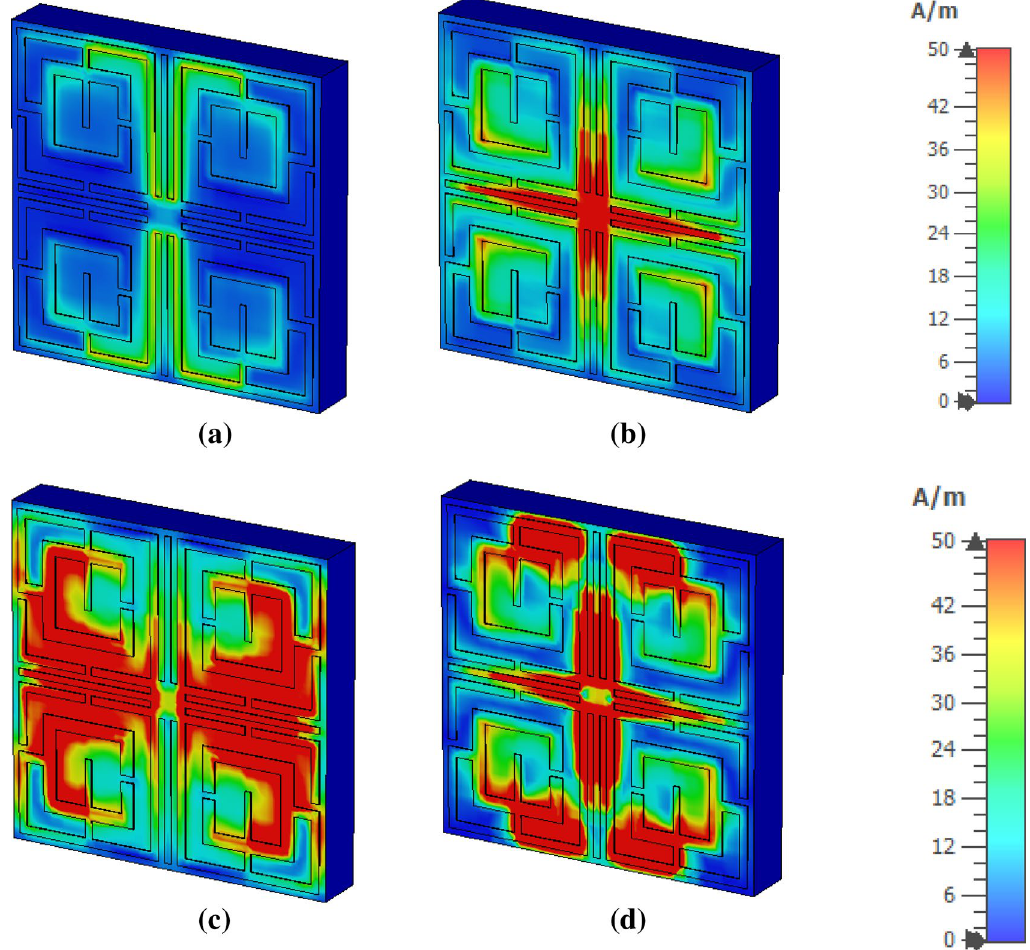
Figure 17. Magnetic field distribution ( a ) 4.2 GHz, ( b ) 10.14 GHz, ( c ) 13.15 GHz, and ( d ) 17.1